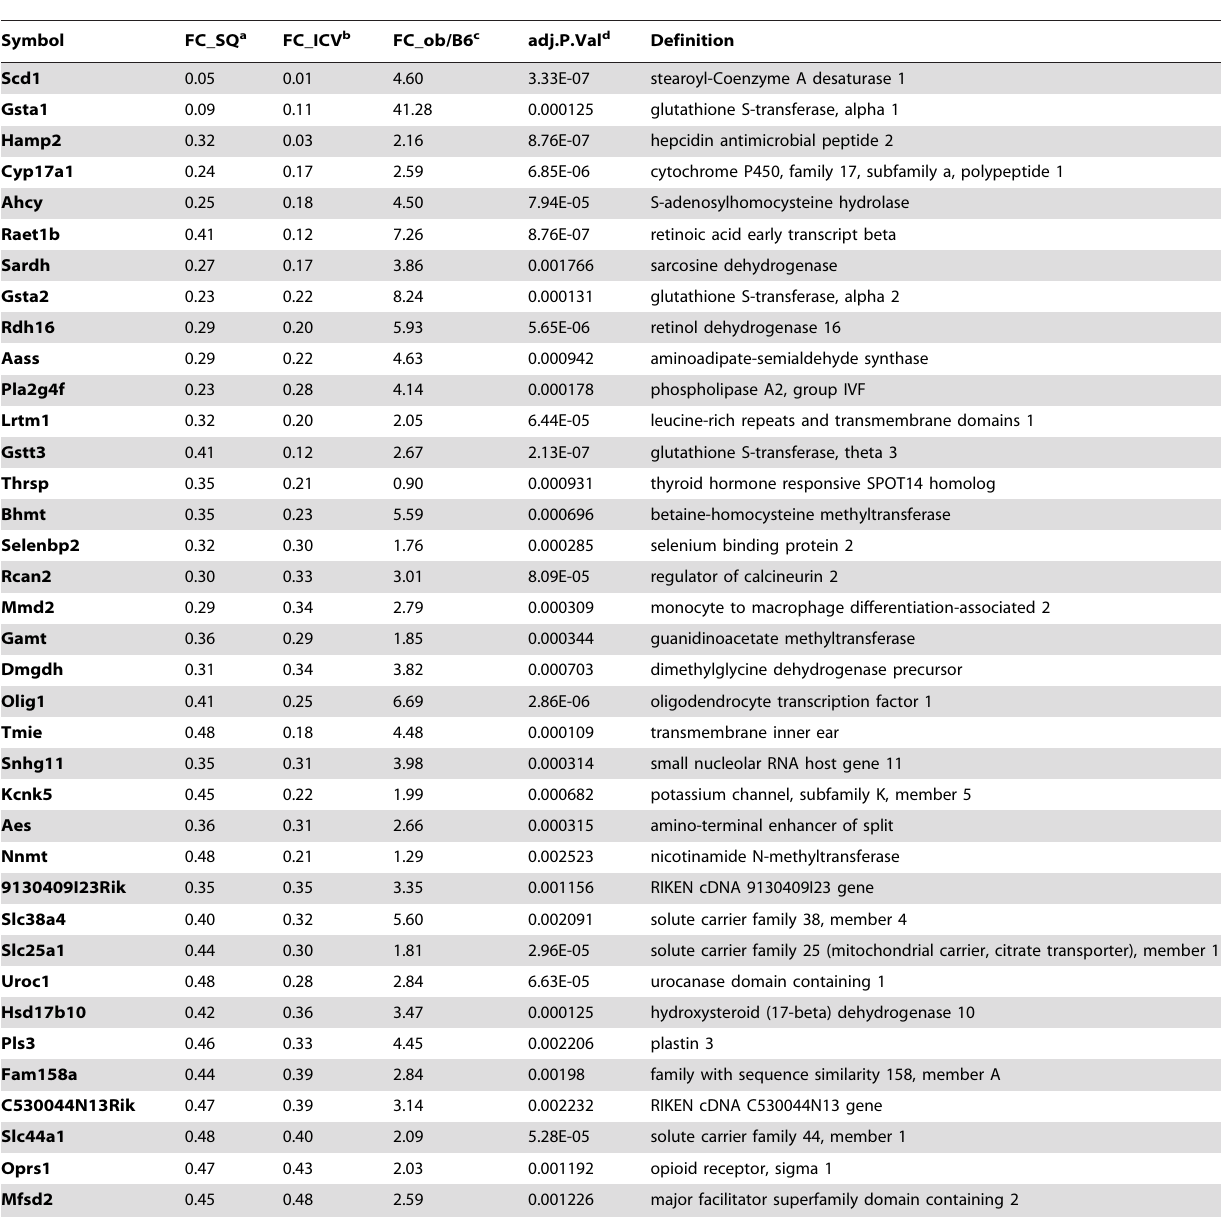
Table 2. Top 37 downregulated genes involved in leptin mediated weight loss.